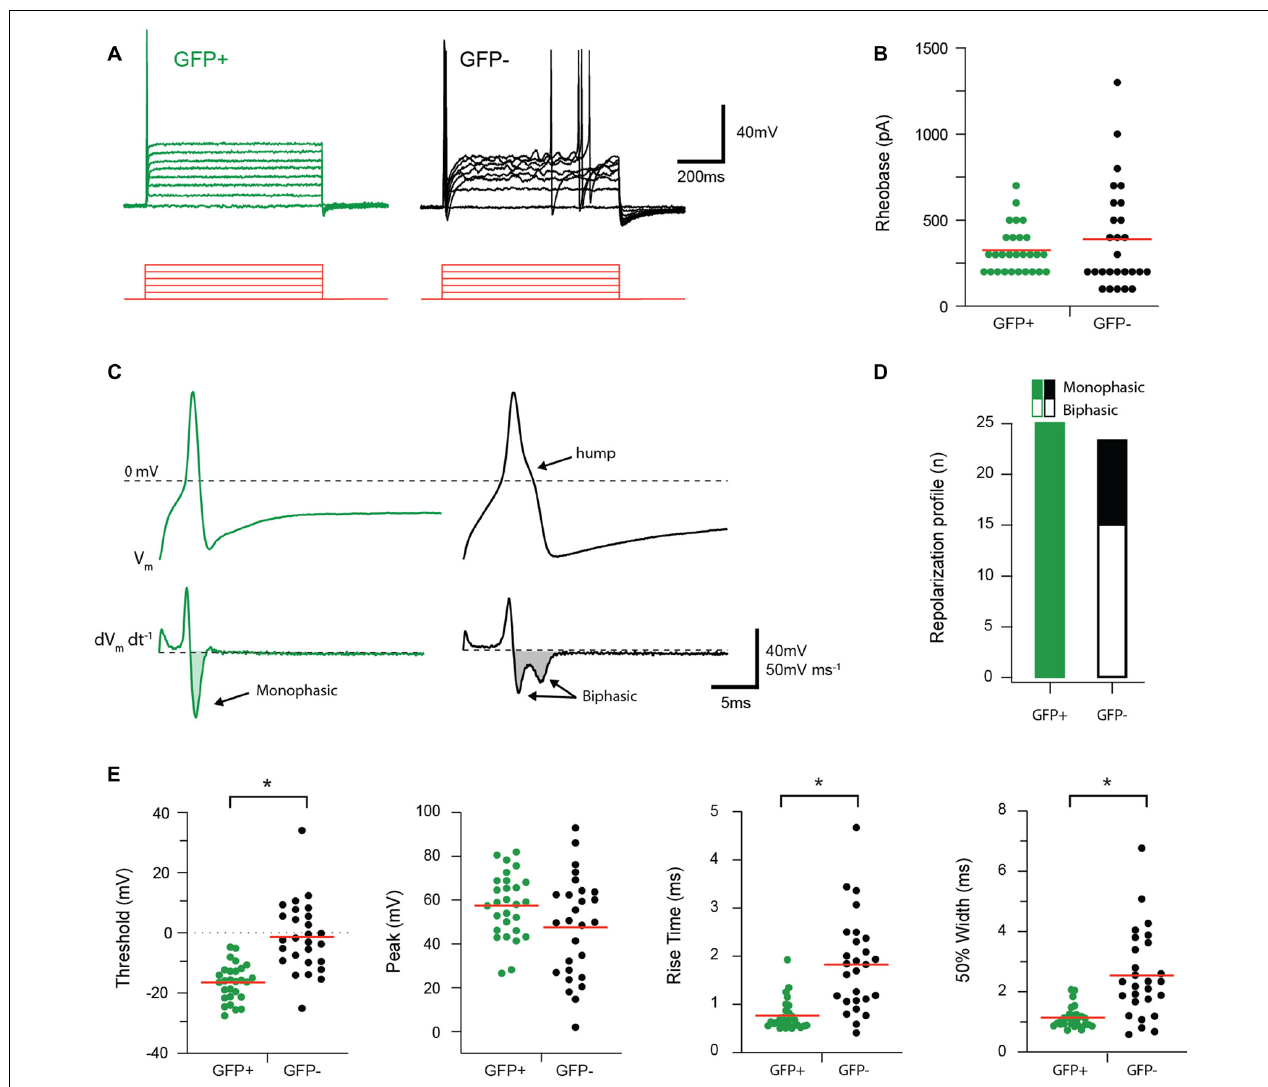
FIGURE 3 | Discharge and action potential (AP) properties of proprioceptive DRG cells. Two types of AP discharge were observed in DRG neurons during step current injections (100 pA increments, 800 ms duration, red traces). (A) Overlaid traces show a typical response from GFP+ and GFP − cells, contrasting a single spike response at the onset of current injection in GFP+ cells with multi-spiking responses observed in some GFP − recordings (7/24). (B) Scatter plot shows group data comparing Rheobase in GFP+ (green circles) and GFP − (black circles) cells. While group means (red lines) are similar for both groups, the spread, and range of data in GFP − cells is greater. (C) Upper traces show rheobase APs from a GFP+ (green trace) and GFP − cell (black trace) on an expanded time scale. Note while APs exhibit a similar amplitude, the time courses are distinct, with GFP+ cells exhibiting faster APs and a distinct hump appearing on the repolarization phase in